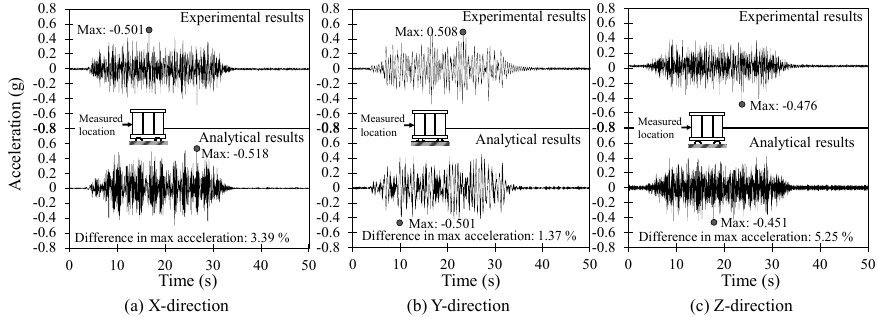
Figure 6. Comparison of acceleration time history responses between analytical and experimental results for AC156_50.